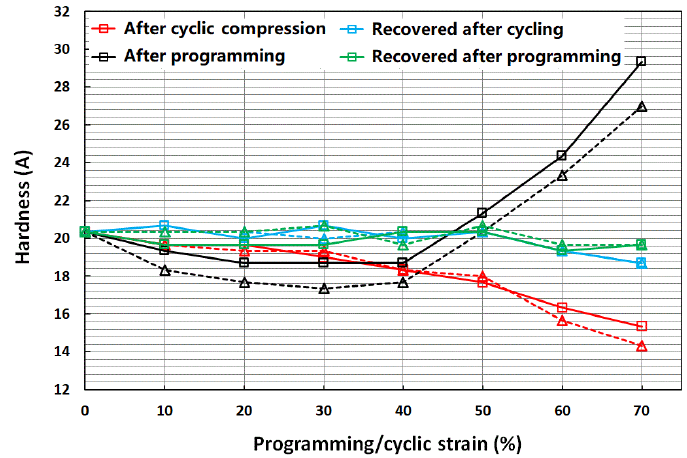
Figure 4. Shore hardness (average) of the top surface of two cylindrical samples (same color) at four different types of tests. different types of